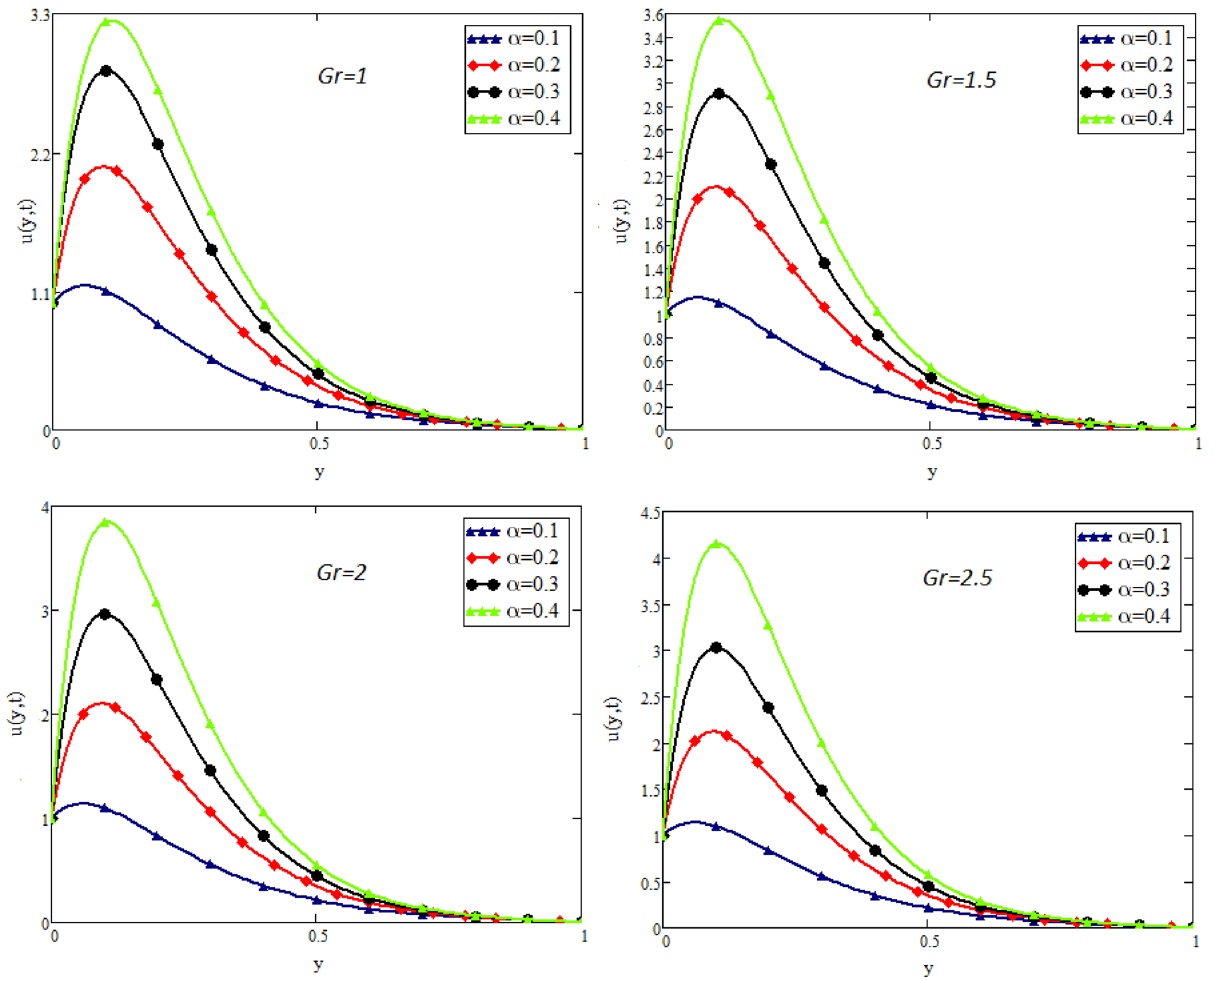
Figure 3. Impact of Gr on velocity distribution when t = 1 , Gm = 1.5 , Pr = 50 , Sc = 20 , β = 2 , and (cid:31) = 1